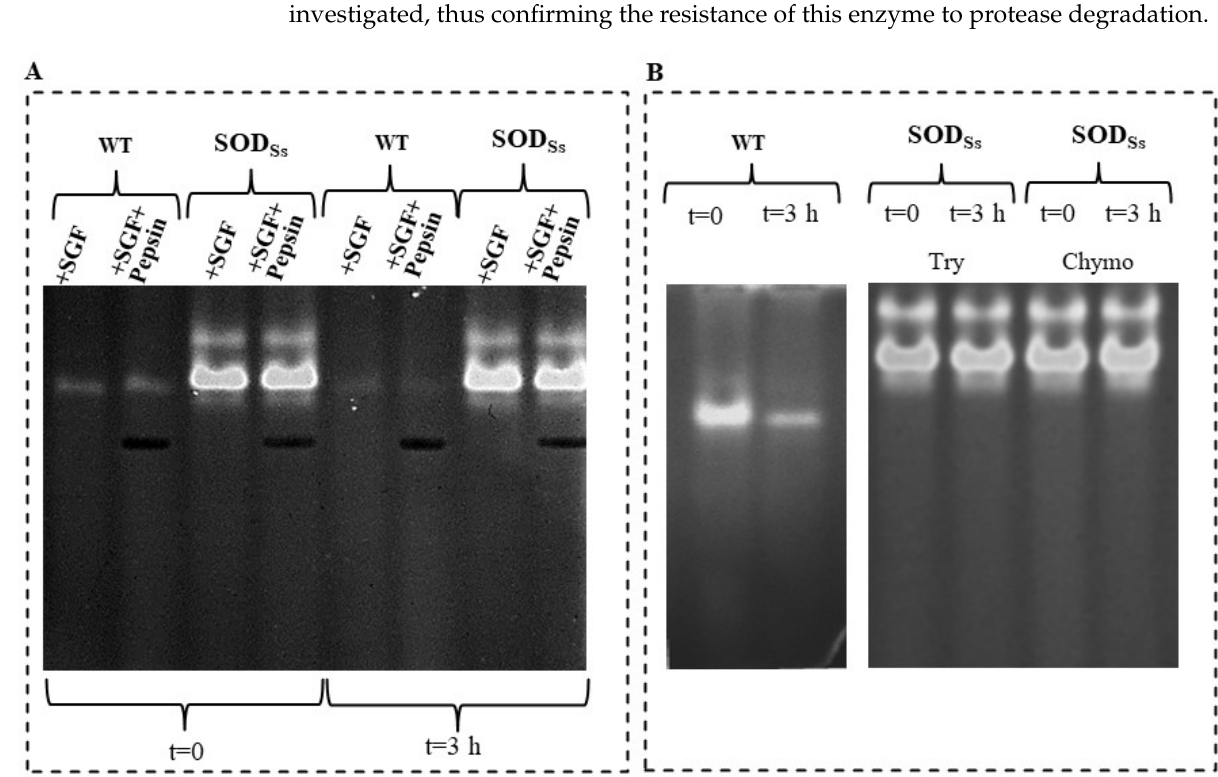
Figure 5 . Proteolytic resistance of SOD Ss -enriched plant extracts. ( A ) Total protein extracts (30 μ g) obtained from non-transformed tomato cell lines (WT) or transformed with sod Ss (SOD Ss ) non-incubated ( t = 0) or incubated for 3 h at 37 °C with simulated gastric fluid (SGF) in the presence or absence of pepsin (9 μ g). ( B ) Total protein extracts (30 μ g) obtained from non-transformed tomato cell lines (WT) non-incubated ( t = 0) or incubated with trypsin (20 μ g) or chymotrypsin (20 μ g) for 3 h at 37 °C; total protein extracts (30 μ g) obtained from tomato cell lines transformed with sod Ss (SOD Ss ) non-incubated ( t = 0) or incubated with trypsin (Try, 20 μ g) or chymotrypsin (Chymo, 20 μ g) for 3 h at 37 °C. Following Native-PAGE (10%) analysis, protein bands were detected by in-gel SOD activity staining using the Riboflavin-NBT method. The results are representative of three independent experiments on three different protein preparations .